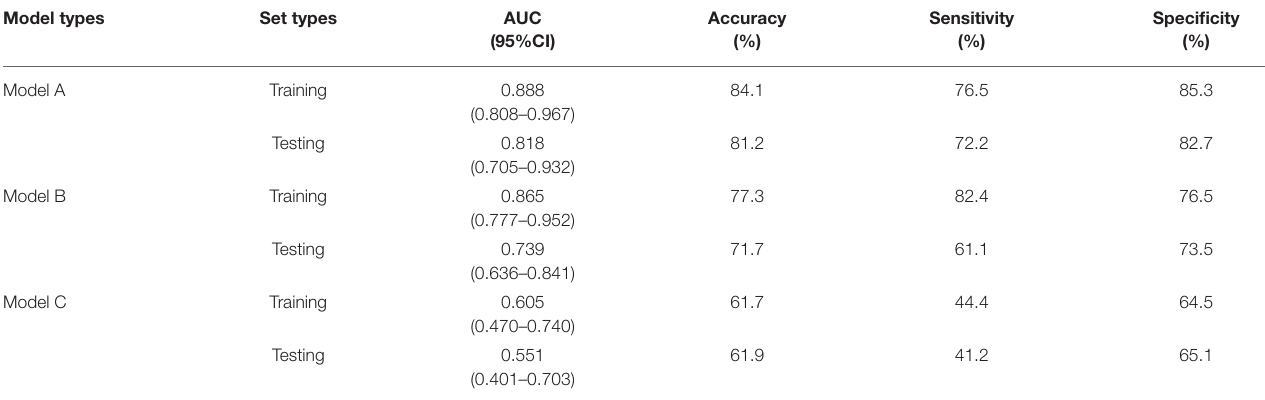
TABLE 3 | Diagnostic performance of models in training and testing set.